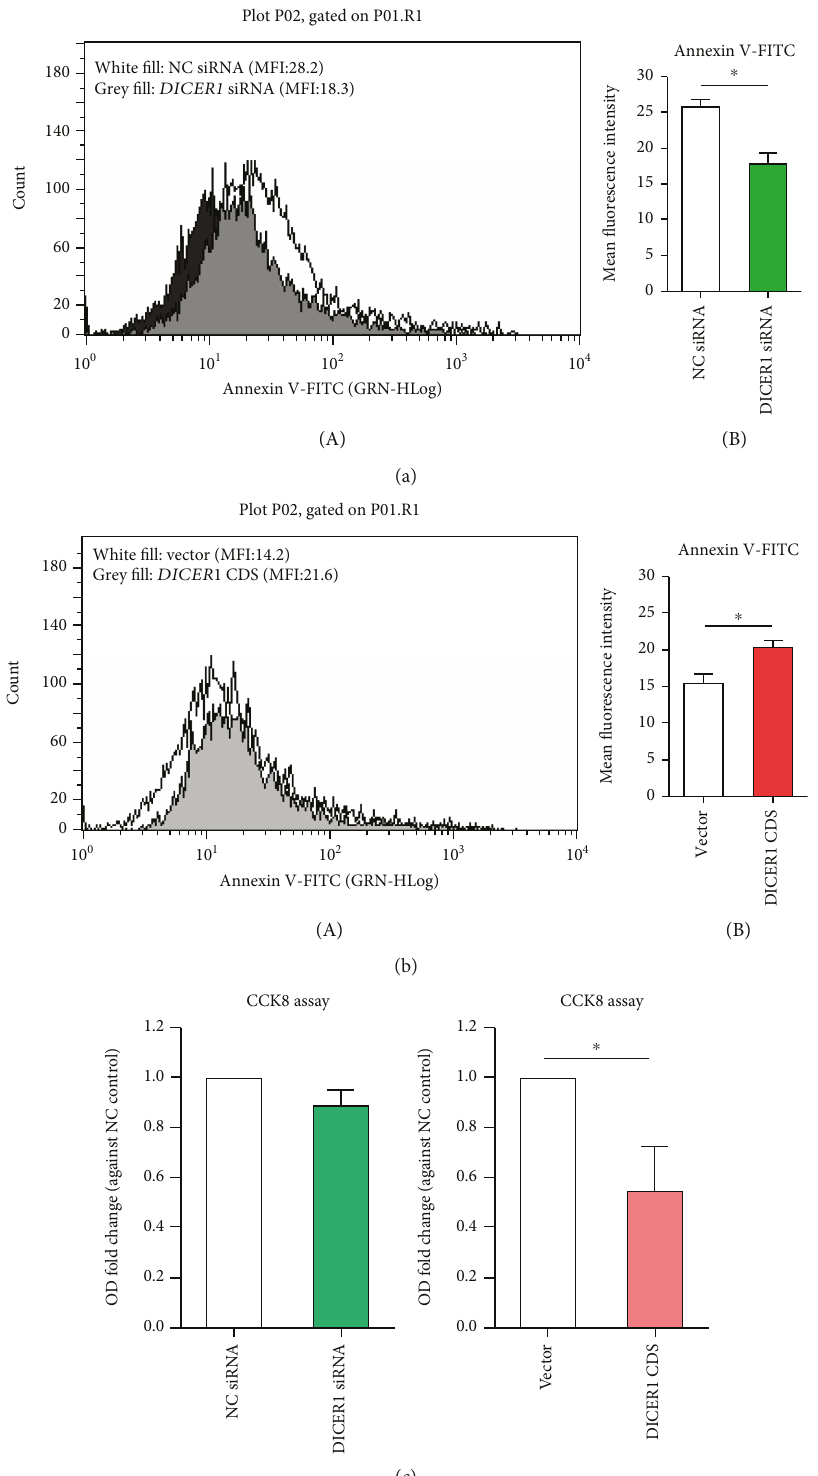
Figure 3: Altered apoptosis and proliferation caused by gain or loss of DICER1 function for 48 h in human synoviocytes SW982. (a) Flow cytometry results of Annexin V-FITC staining after DICER1 siRNA transfection for 48 h. (A) Representative histogram; (B) quantitative analysis of mean fl uorescence intensity. (b) Flow cytometry results of Annexin V-FITC staining after DICER1 was overexpressed for 48 h. (A) Representative histogram; (B) quantitative analysis of mean fl uorescence intensity. (c) Cell counting kit-8 assay for cell proliferation detection. Bar: mean ± SEM from three independent transfection experiments, and triplicates were used for each transfection experiment. ∗ P < 0 05 using the Mann-Whitney